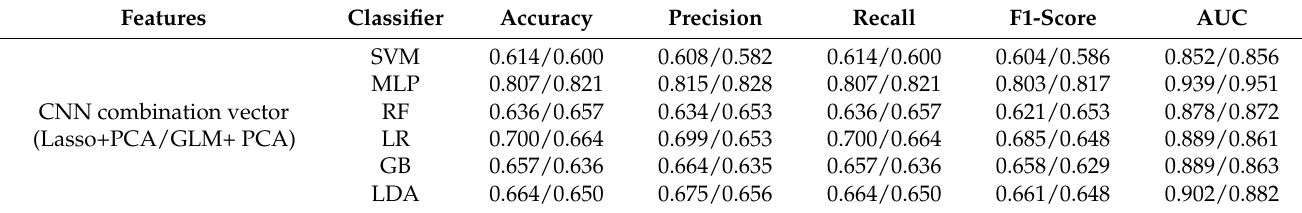
Table 6. The different ML classifiers’ performance on the test set of the CNN combination vector (Lasso + PCA/GLM + PCA) in Experiment 1.